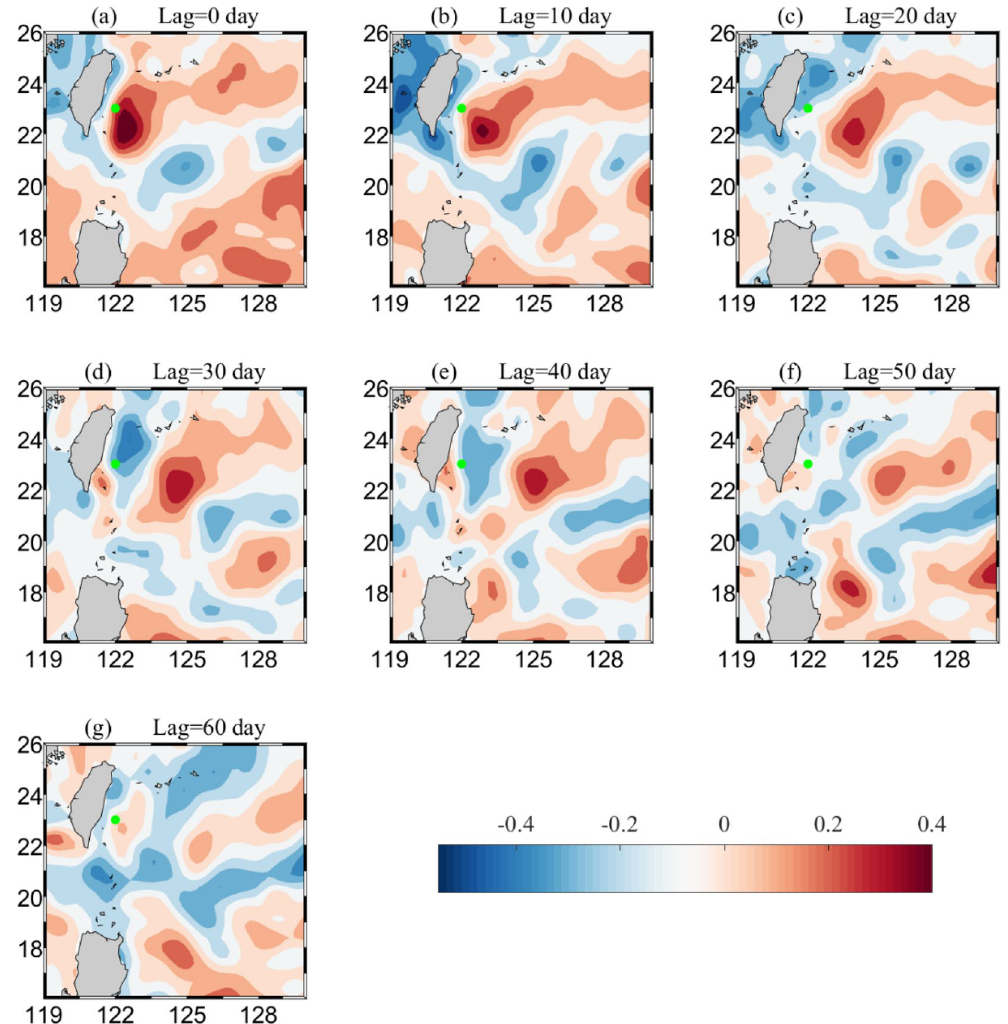
Figure 7. Maps of correlation coefficients between SLAs and minimum salinity of IW. Salinity lagged SLA by ( a ) 0 days, ( b ) 10 days, ( c ) 20 days, ( d ) 30 days, ( e ) 40 days, ( f ) 50 days and ( g ) 60 days. Color shading indicates the value of the correlation coefficient, with red (blue) indicating a positive (negative) correlation. The location of the mooring site is indicated by green dot. Figures were plotted using MATLAB R2016b (http:// www. mathw orks.